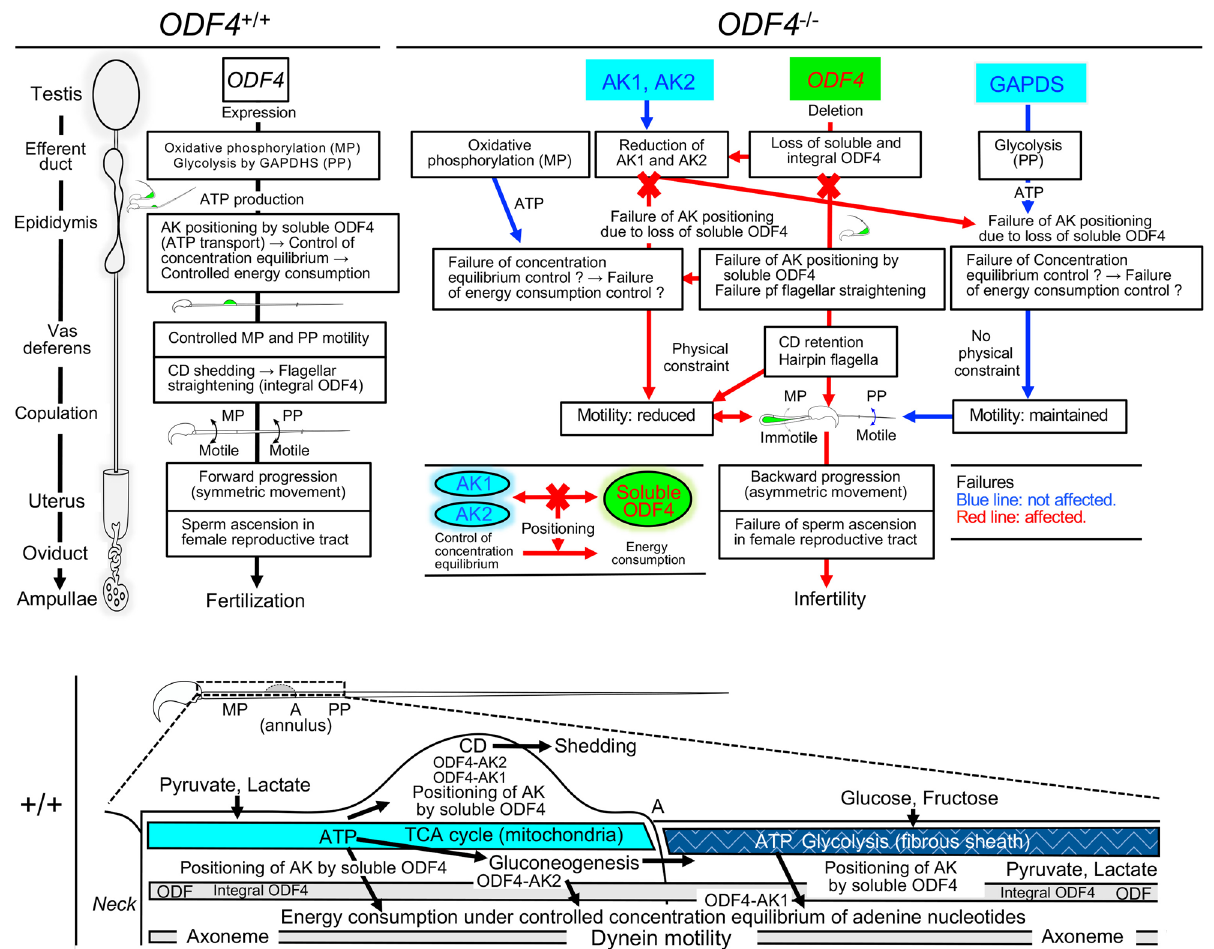
Figure 8. Summary of the present data (Top) and possible interplay of ODF4, AK1 and AK2 in Odf4 +/+ spermatozoa (Bottom). (Top, left) In Odf4 +/+ spermatozoa, soluble ODF4 associates with AK1 and AK2. Flagellar shape (straightening) and forward progression are controlled. (Top, Right) In Odf4 −/− spermatozoa, Odf4 deletion primarily causes the loss of integral and soluble ODF4 in the testis and secondarily causes reduction of AK1 and AK2 in mature sperm flagella; eventually, a hairpin flagellum with a large cytoplasmic droplet (CD) appears and shows backward progression, leading to male infertility. A detailed explanation is provided in the Discussion. (Bottom) The energy production and consumption system normally works under controlled conditions of concentration equilibrium of adenine nucleotides, where ODF4, AK1 and AK2 are present. The ATP produced by the TCA cycle is normally transported, mainly by the ODF4-AK2 complex, to the energy-consuming site (CD) and axonemal dynein in the midpiece, while the ATP produced by glycolysis is mainly transported by the ODF4-AK1 complex to the energy-consuming site (axonemal dynein in the principal piece). The transported ATP will help shed the CD and maintain movement in the midpiece and principal piece. MP midpiece, PP principal piece, Top, Bottom: drawn by Toshimori,